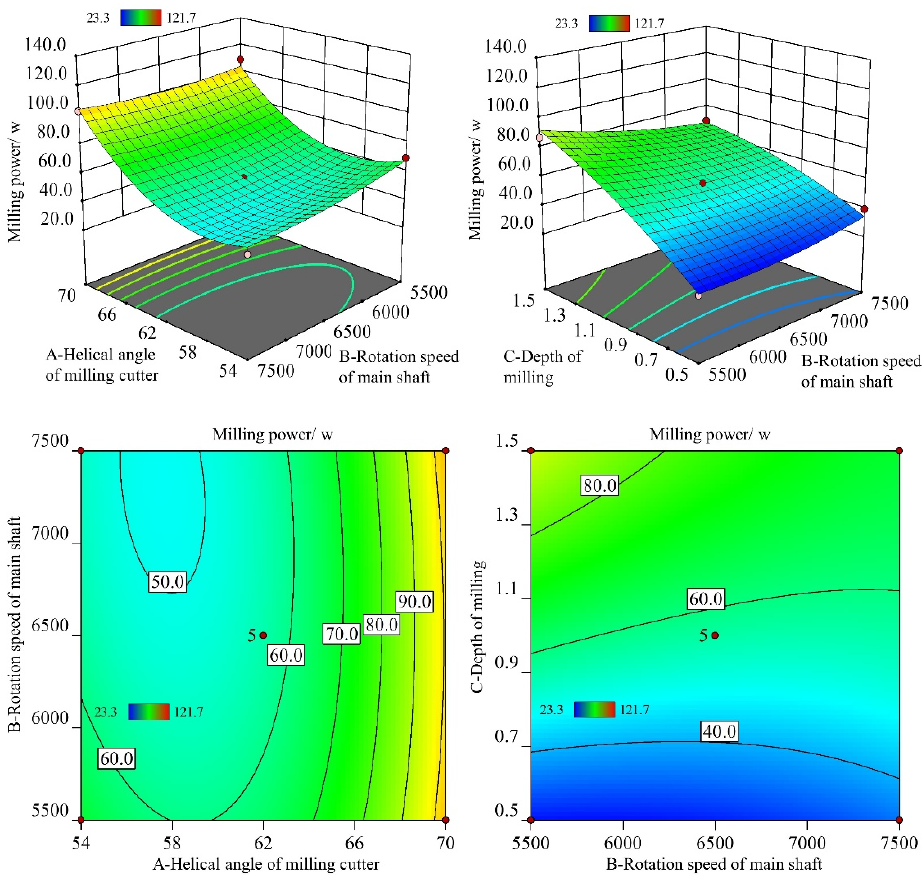
Figure 5. The 3D surface and contour graphs for milling power.